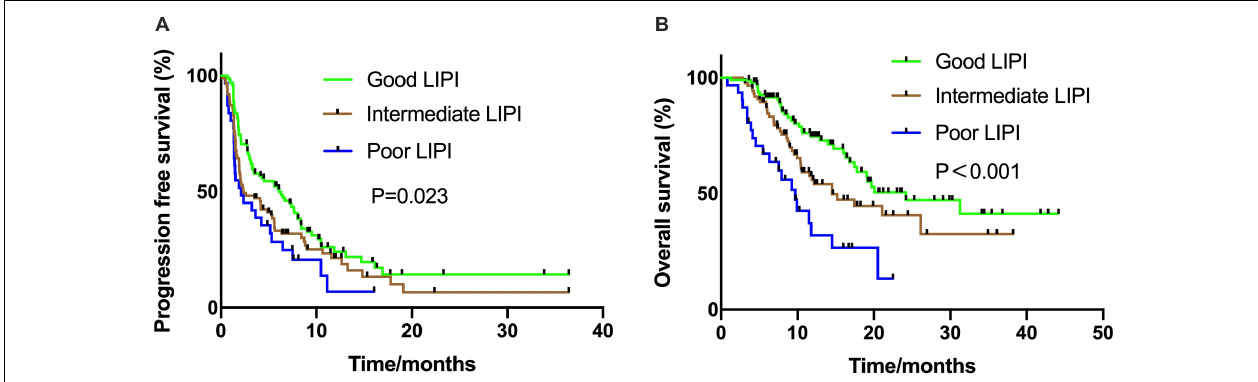
FIGURE 1 | Kaplan Meier estimates of progression-free survival (PFS) and overall survival (OS) according to the Lung Immune Prognostic Index (LIPI) groups in patients with ICI monotherapy (A) PFS in the ICI monotherapy group ( P = 0.023); (B) OS in the ICI monotherapy group ( P < 0.001).